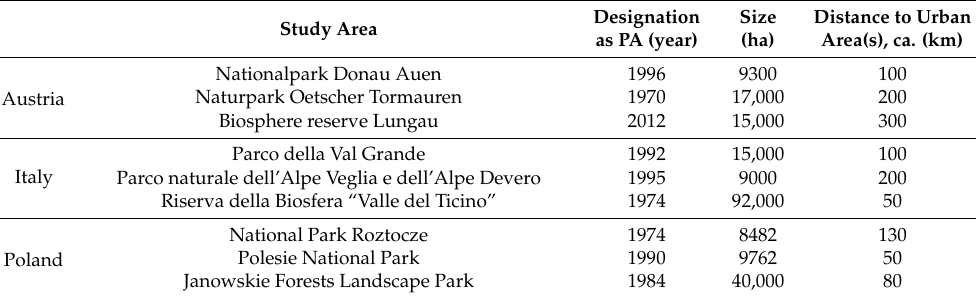
Table 1. List of study areas and their general characteristics.